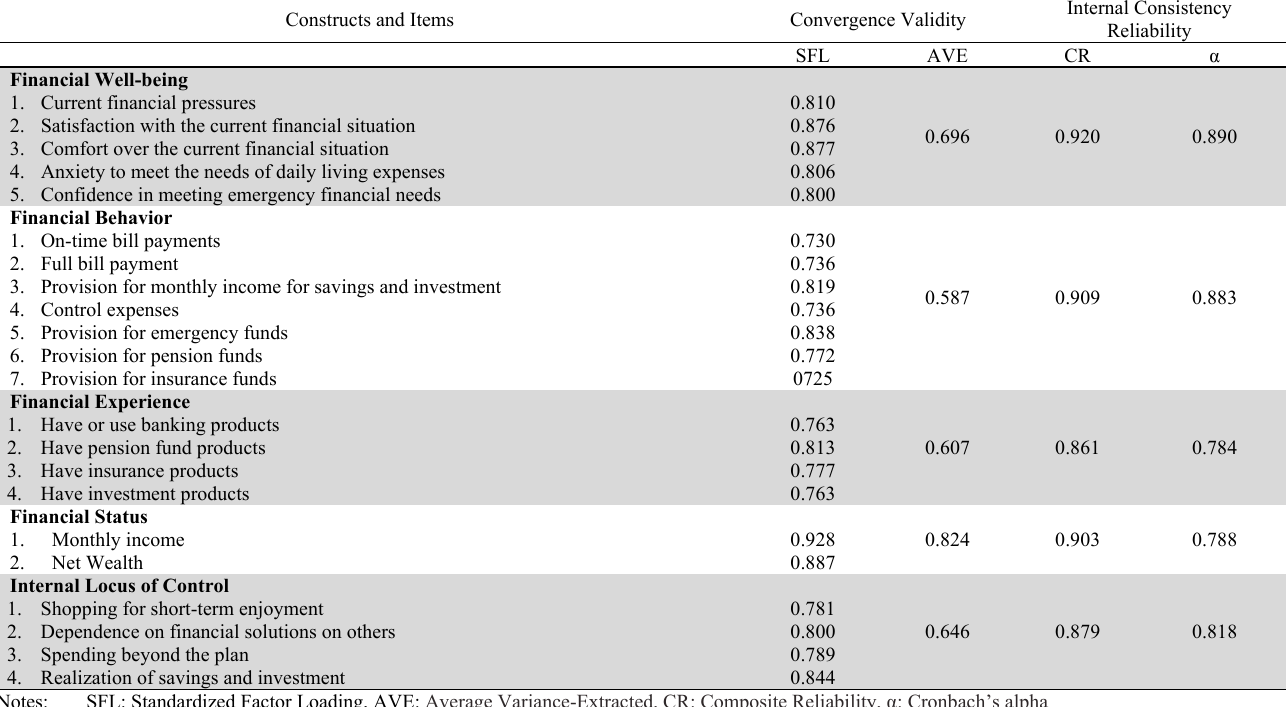
Measurement, Validity, and Reliability Constructs and Items Convergence Validity